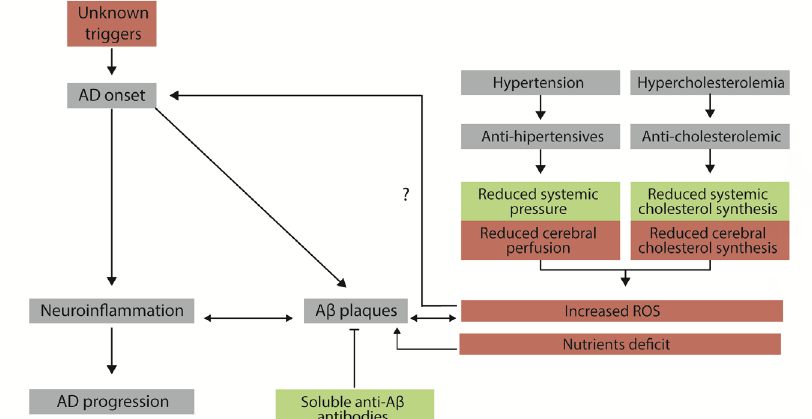
Figure 2. Diagram showing the basis of the drug-focused neurodegeneration hypothesis. Events are useful for patients with high blood cholesterol and/or high blood pressure are in green. Events that may be harmful to patients’ CNS neurons are in red. Mechanisms associated with the initiation and progression of AD are in grey. Aβ: β-amyloid; ROS: reactive oxygen species;